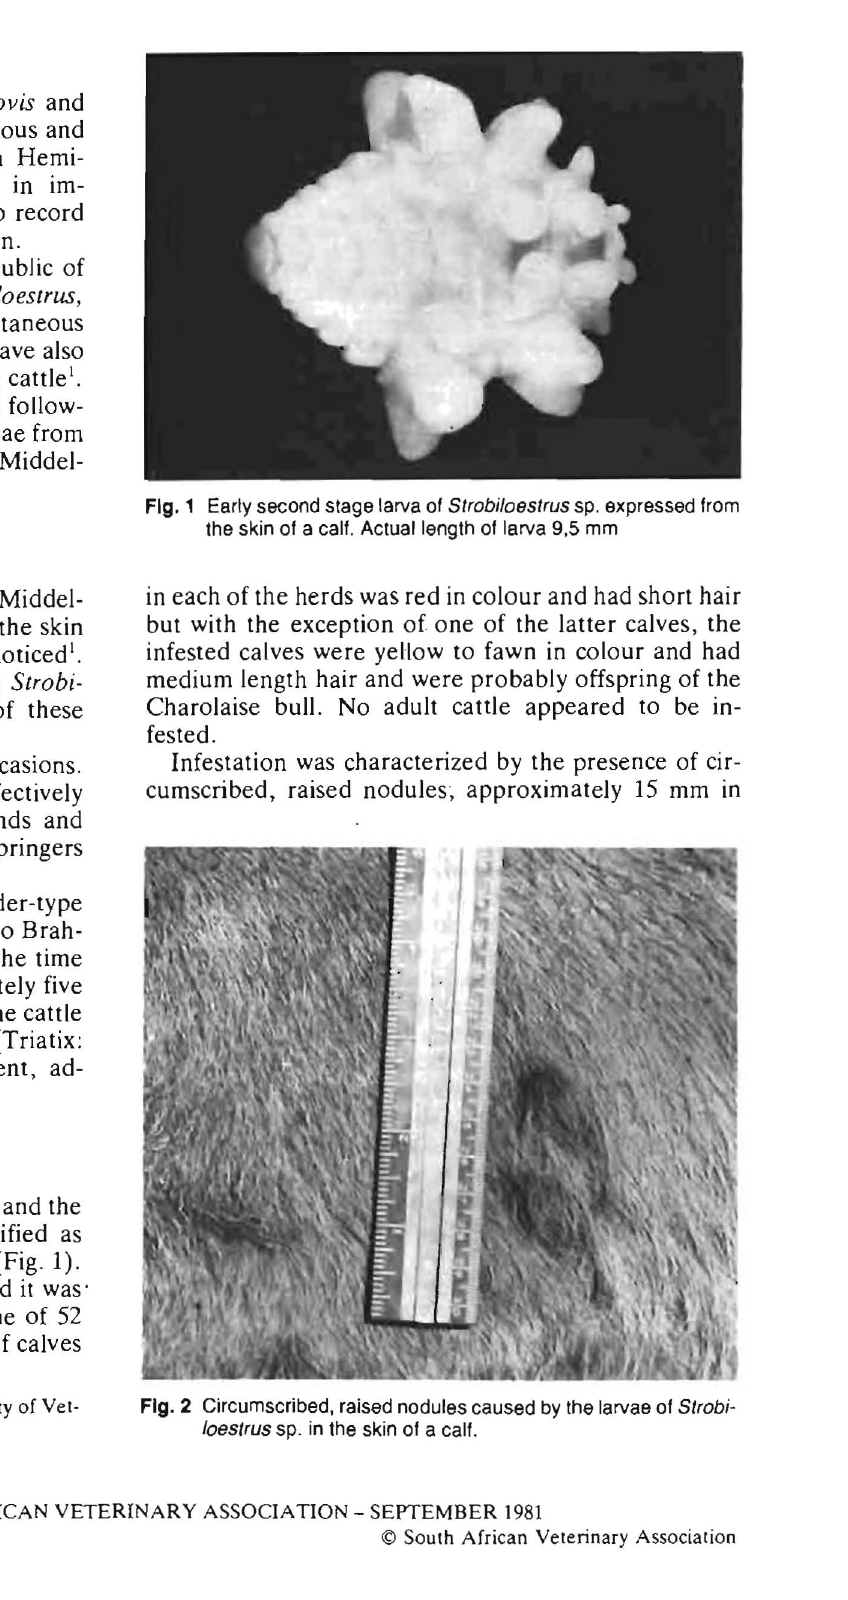
Fig. 2 Circumscribed. raised nodules caused by the larvae of Strobi loestrus sp. in the skin of a